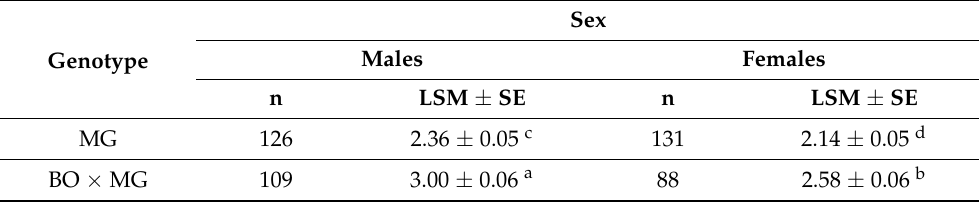
Table 7. Least Square Means (LSM ± SE) of the birth weight (kg) of kids according to genotype (crossbred and purebred) × sex interaction. Crossbred kids were from Boer bucks × Murciano- Granadina goats (BO × MG). Purebred kids were Murciano-Granadina breed (MG).